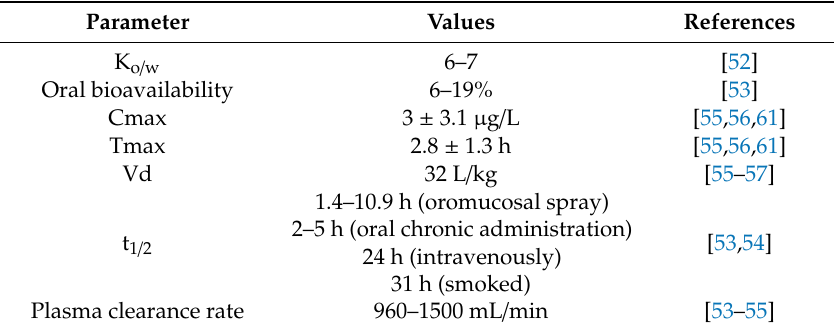
Table 1. Main pharmacokinetics parameters of cannabidiol